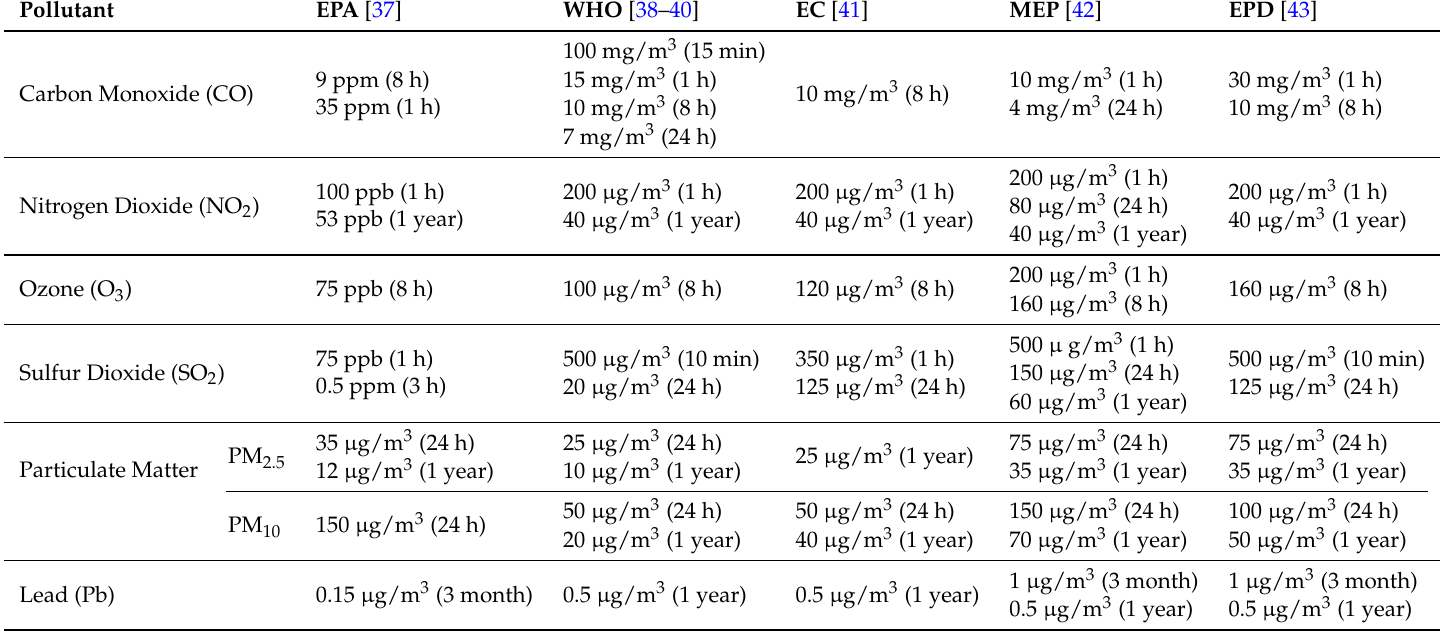
Table 3. Different standards of the six common